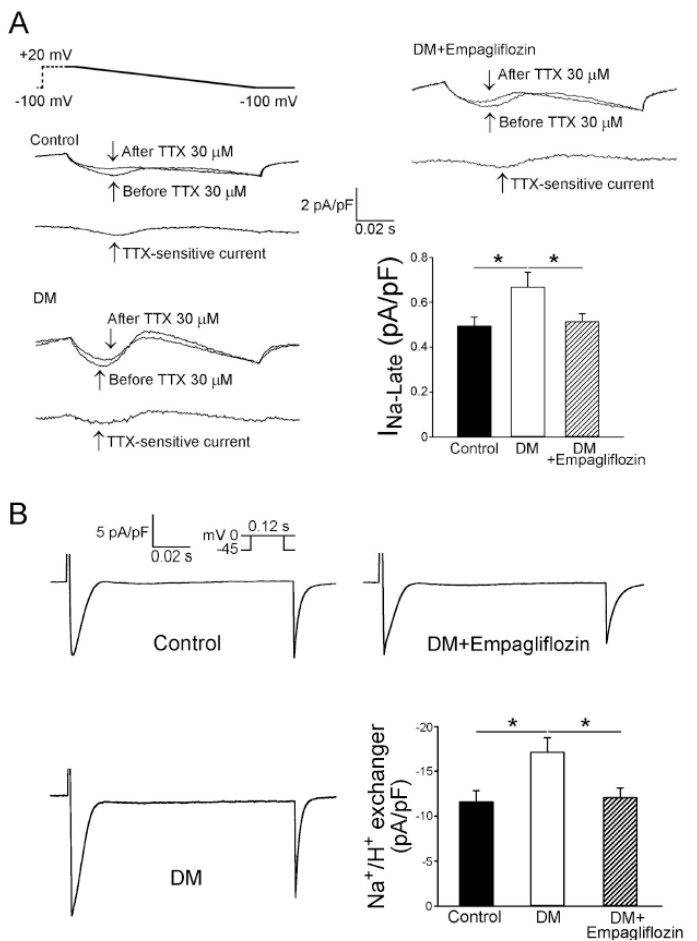
Figure 4. Late sodium current (I Na-Late ) and sodium hydrogen (Na + /H + ) exchanger current of ventricular myocytes from control, diabetes mellitus (DM), and empagliflozin-treated DM (DM + empagliflozin) rats. ( A ) Representative tracing of current and average data of the I Na-Late of ventricular myocytes from control ( n = 18), DM ( n = 15), and DM + empagliflozin ( n = 16) rats. ( B ) Representative tracings of current and average data of the Na + /H + exchanger of ventricular myocytes from control ( n = 17), DM ( n = 18), and DM + empagliflozin ( n = 19) rats. n = number of cardiomyocytes isolated from those rats; * p < 0.05.